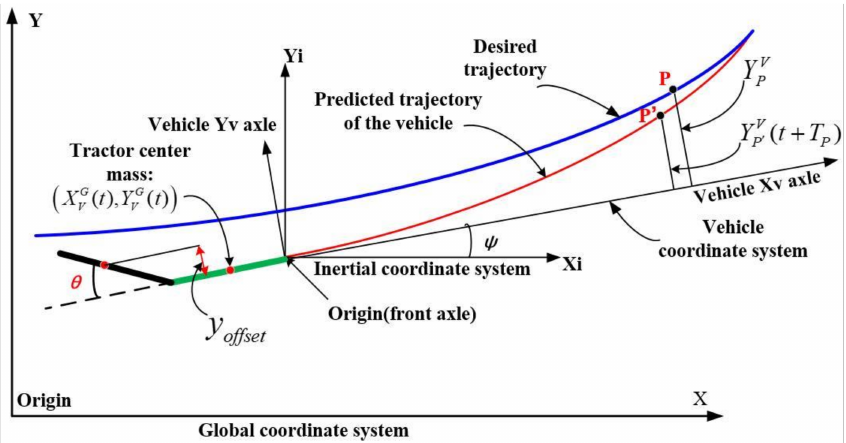
Figure 4. Preview principle of